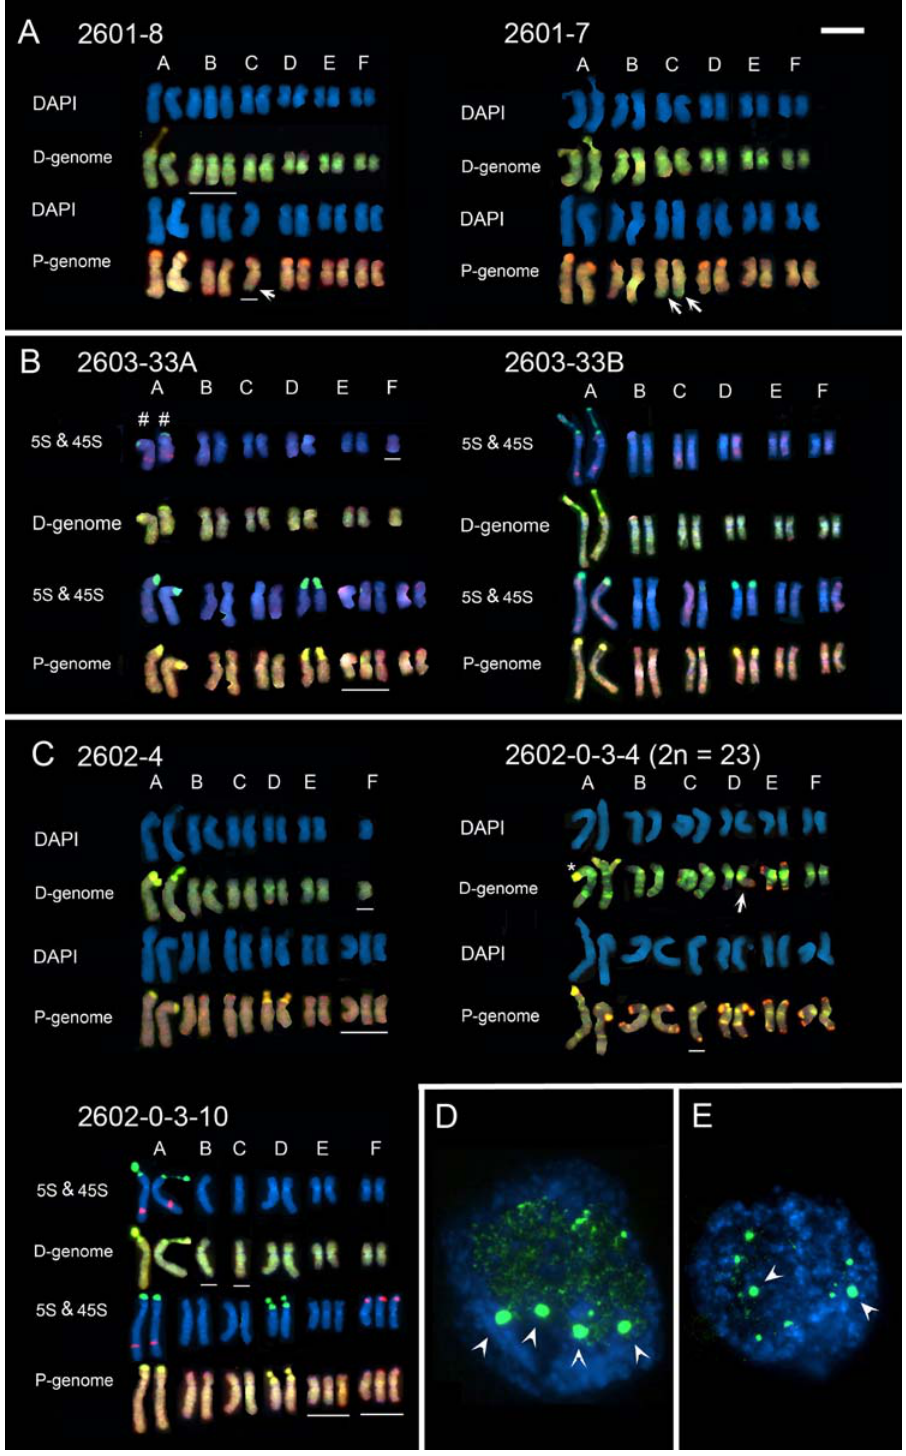
Figure 2. (A-C) Karyotype analyses of T.mirus from individuals in three populations (A) 2601, (B) 2603 and (C) 2602. Homeologous chromosome group nomenclature (A-F) follows Ownbey and McCollum [25] and Pires et al. [24]. Fluorochrome colours: yellow/green (FITC, digoxigenin-labelled probes), orange/red (Cy3, biotin-labelled probes), blue (DAPI staining). Each karyotype is shown with DAPI staining, sometimes also simultaneously labelled for 45S rDNA (yellow fluorescence) or 5S rDNA (red fluorescence), and after GISH with T. dubius (green fluorescence) and T. porrifolius (red fluorescence) total genomic DNA probes. Monosomic or trisomic chromosomes are underlined. Note: (1) intergenomic translocations to chromosome C po/du (arrows) in individuals 2601-7 and 2601-8 and D du/po in individual 2602-0-3-4 (A). (2) The 45S rDNA locus on the two homologues of chromosome A du in individuals 2602-4 and 2602-0-3-4 show different levels of decondensation, one being condensed and the other with a secondary constriction (C). (3) A large reduction in size of the 45S rDNA locus on chromosome A du of individual 2603-33A ( # ) compared with other individuals (D). (4) No secondary constrictions of 45S rDNA loci on T. porrifolius origin chromosomes (A po , D po ) in individual 2603-33B. (D-E) Root-tip interphase nuclei of T. mirus after FISH with digoxigenin-labelled pTa71 for 45S rDNA. (D) Individual 2601-4, showing four large condensed 45S rDNA loci (arrows) and (E) Individual 2602-0-3-10 with two large condensed 45S rDNA loci (arrows). Scale bar (top right) is 10 m m. doi:10.1371/journal.pone.0003353.g002 PLoS ONE |